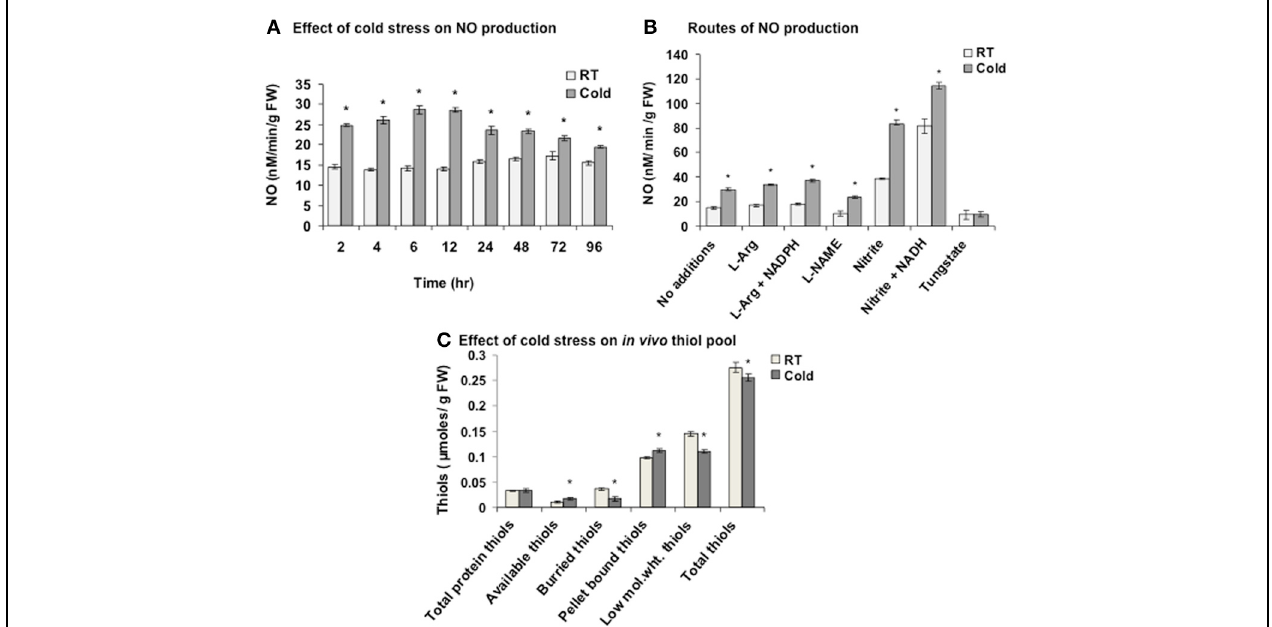
FIGURE 1 | Nitric oxide (NO) and in vivo thiol pool measurement in cold. (A) NO production measured using NO measuring system after the cold treatment (2–96h) to the seedlings. (B) NO production in the extract from control (room temperature, RT) and cold (4 ◦ C) treated seedlings with L-arginine (L-Arg, 1mM) alone or with NADPH (1mM), L-NAME (1mM), nitrite (1mM) alone or with NADH (1mM)